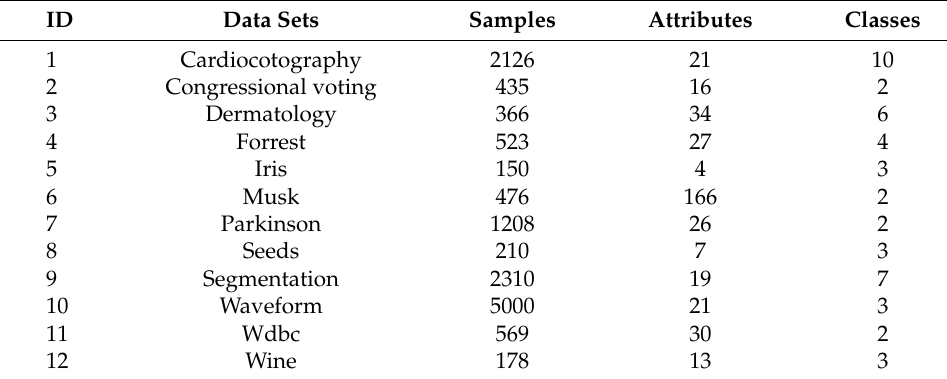
Table 1. A description of UCI data sets.